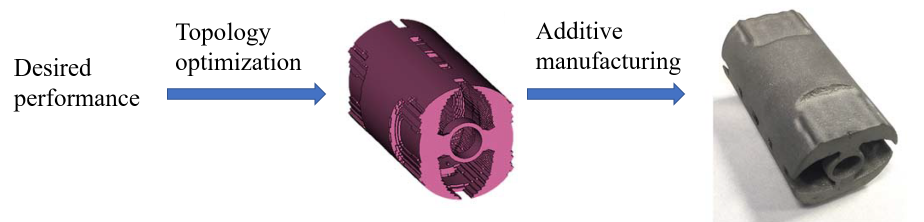
Figure 16. Optimized rotor core via coupled magnetic-structural TO. The design is then additively manufactured via SLM. Figure is modified from